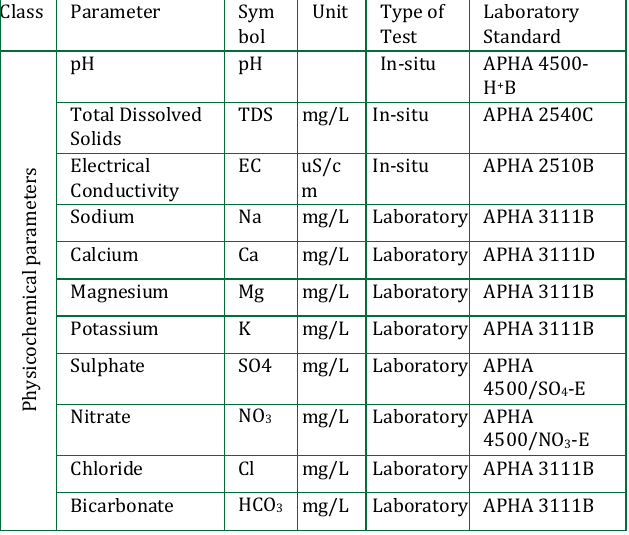
Analytical methods used for groundwater samples